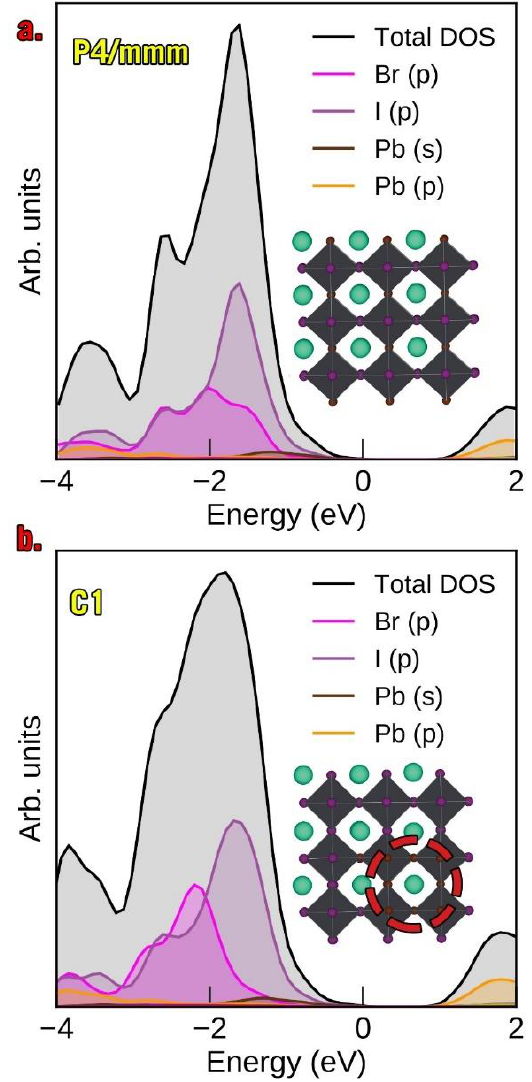
Figure 6. The partial density of states of ( a ). α -CsPbI 3 P4/ mmm and ( b ). α -CsPbI 3 C1 (cluster type).